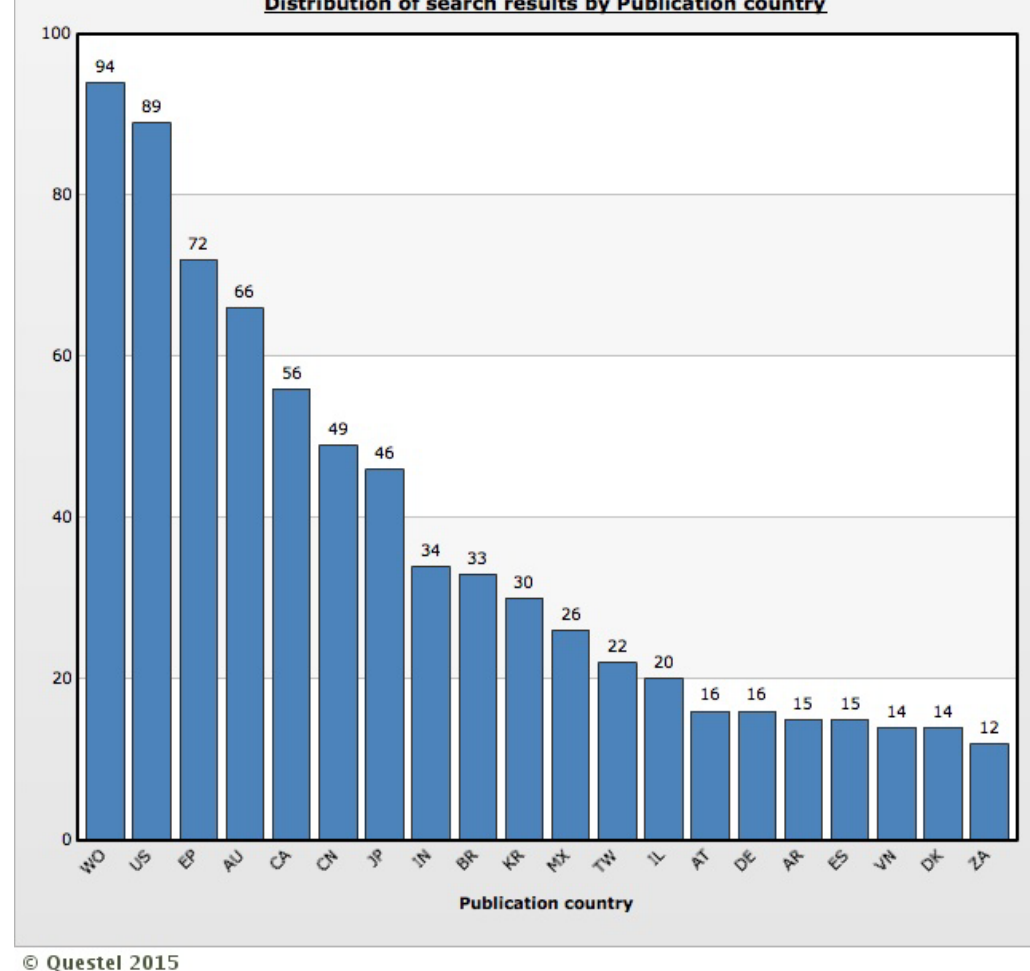
Figure 3. Distribution of number of published patents by top 20 publication countries.